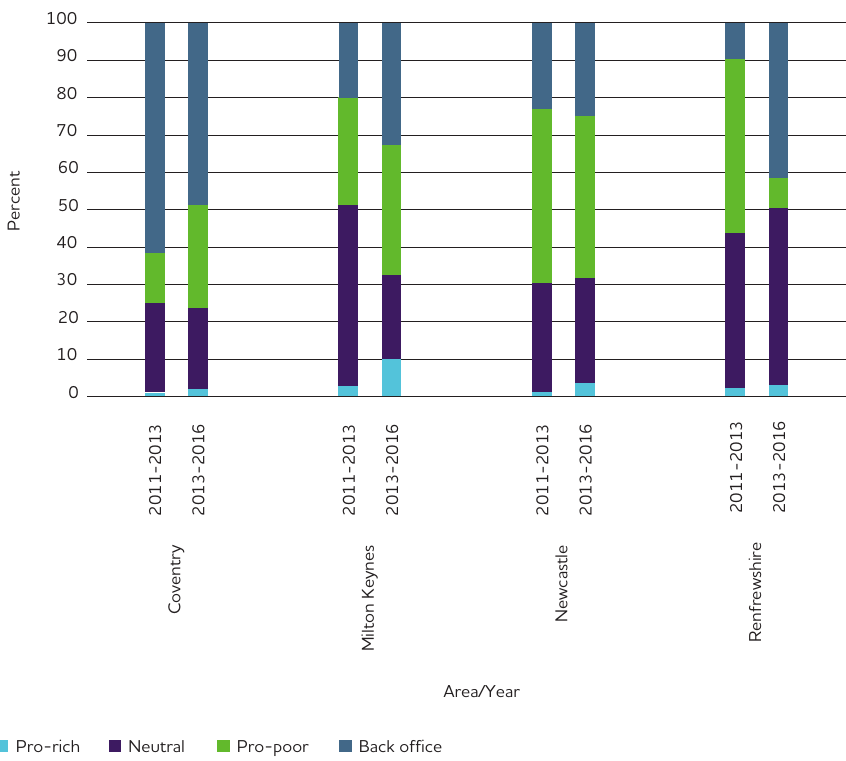
Figure 22: Proportion of savings by distributional character of